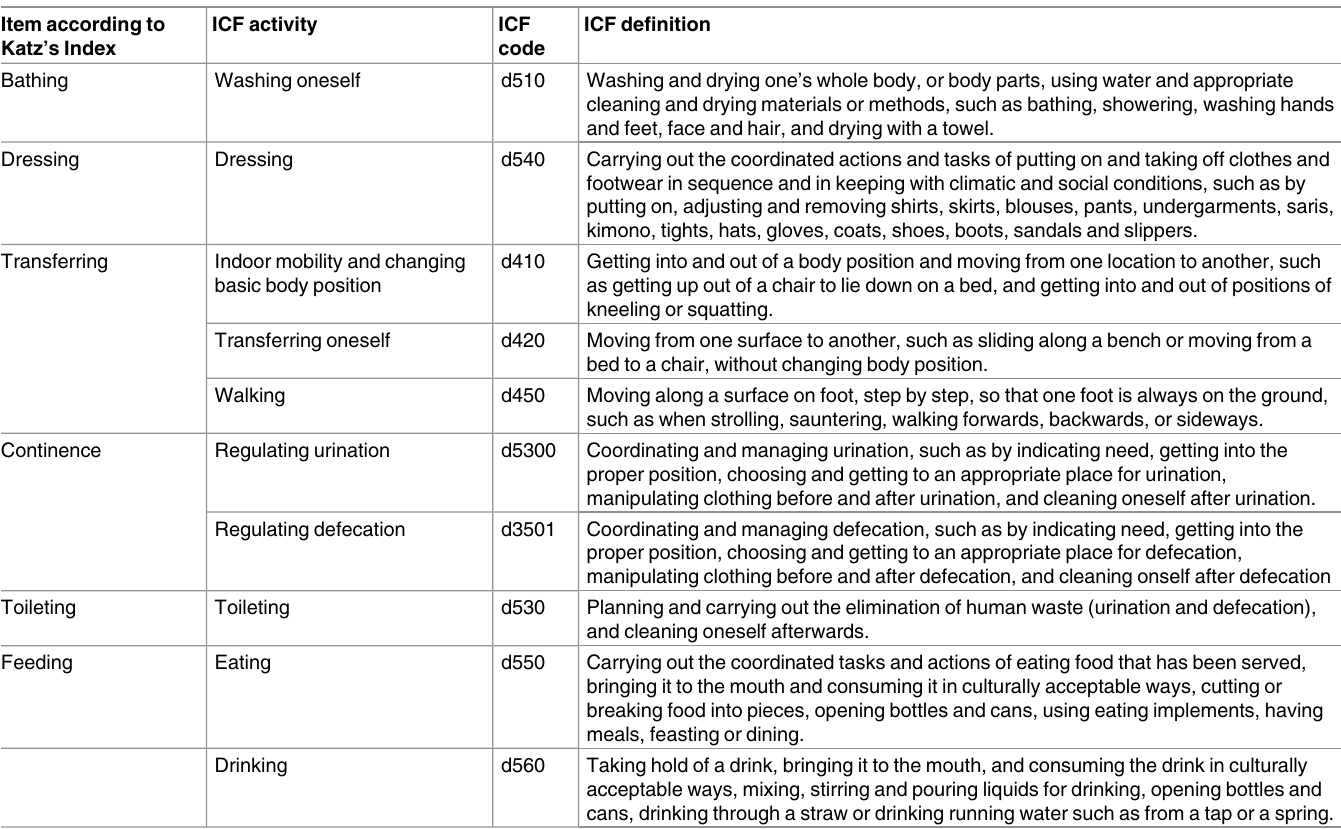
Table 1. Items of the Katz Index according to the codes and definitions of the